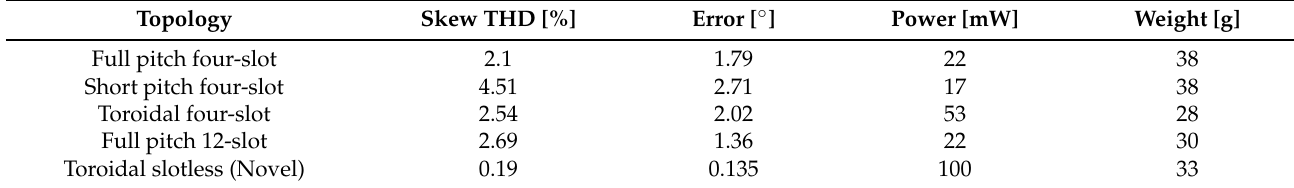
Table 2. Results obtained with the studied resolver topologies.